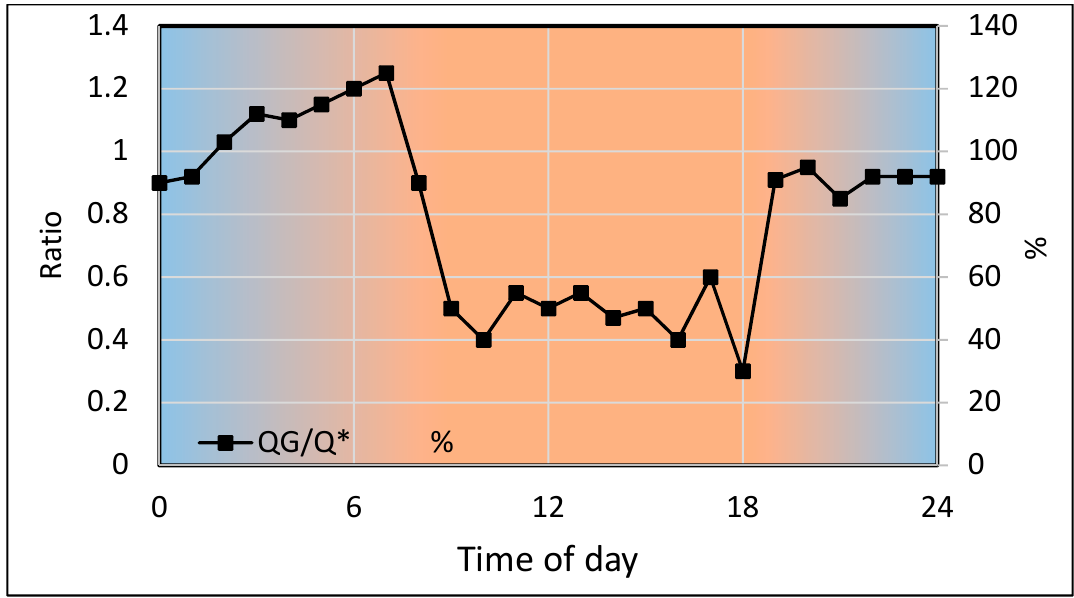
Figure 3. Ratio of storage heat fluxes Q G (as percentages of Q * on secondary axe), normalized by net radiation, from 20 clear-sky days during the BUBBLE-field campaign in Basel, Switzerland (station Basel-Spalenring).